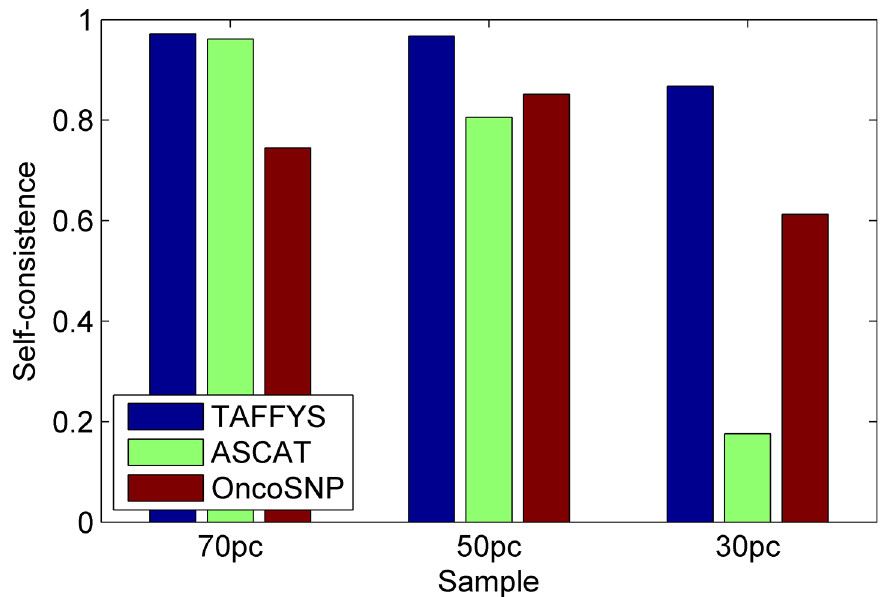
Fig 4. Assessment of different methods using dilution series data. Self-consistency for copy number identification by TAFFYS (blue), ASCAT (green) and OncoSNP